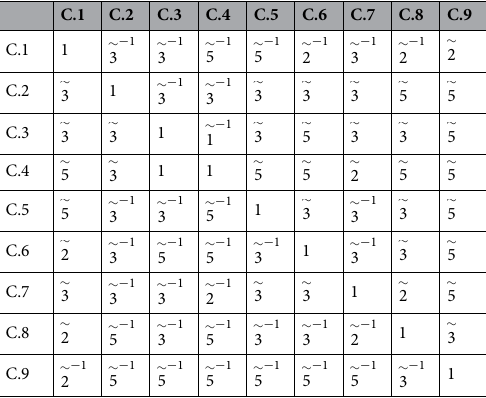
Table 7. Pairwise comparison matrix.